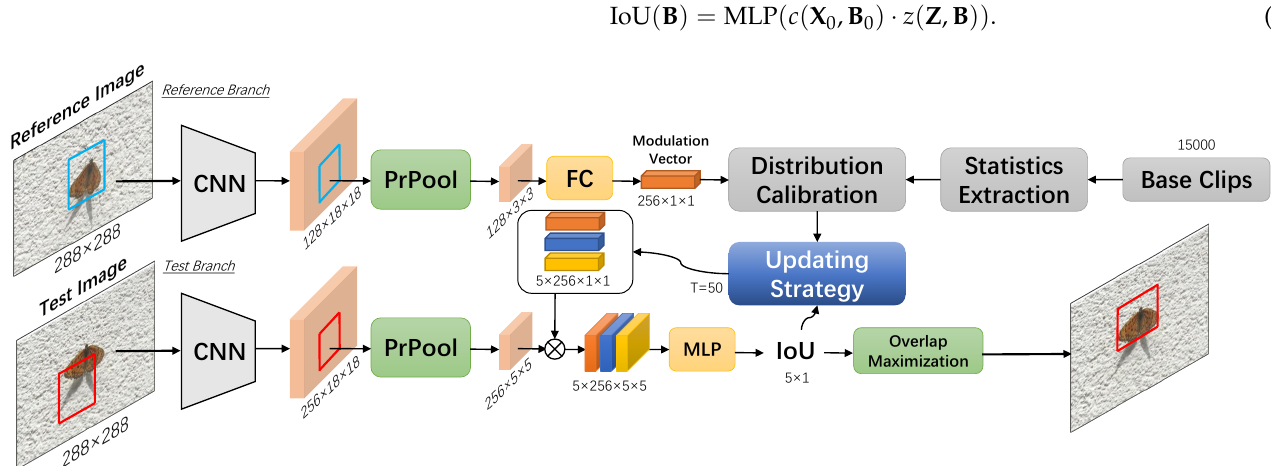
Figure 2. An overview of the proposed DCOM. The CNN module is composed of the backbone network and an extra convolution layer, and the MLP (multi-layer perception) consists of three fully connected